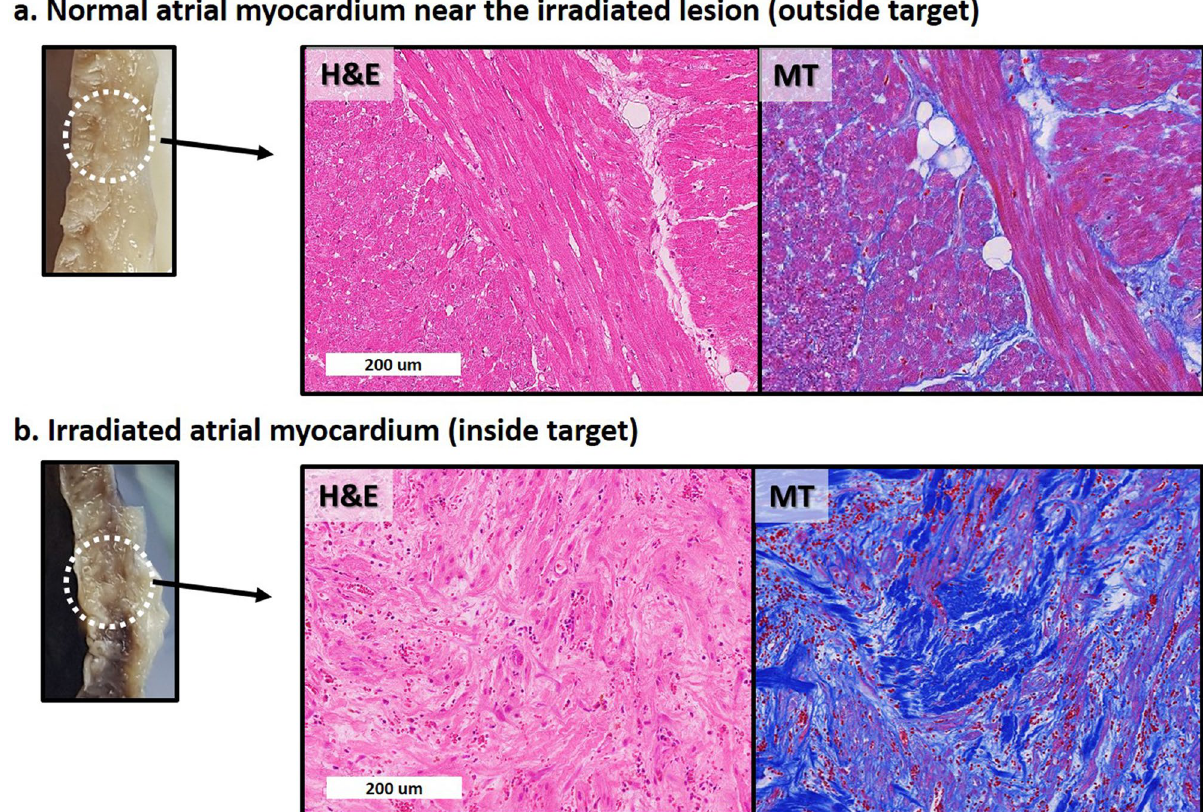
Figure 5. Histologic changes after irradiation observed at 4 months. A visually definite transmural necrotic lesion is observed on the irradiated area at 4 months. Compared to the normal atrial myocardium near the irradiated lesion ( a ), irradiated atrial myocardium ( b ) shows massive hemorrhage with anucleated wavy fibers with extensive interstitial fibrosis. H&E hematoxylin and eosin, MT Masson’s and therefore, we selected a higher RT dose of 33 Gy rather than a dose of 25 Gy used in the VT treatment with SABR and the irradiated atrial myocardium showed transmural fibrosis. The heterogeneity of the border zone between the irradiated and non-irradiated zones could be the arrhythmogenic substrate in the context of micro-reentry or triggered activity. However, the irradiated myo- cardium was well-demarcated from the adjacent normal myocardium, as displayed in Supplementary Fig. S4, and the width of the border zone was only a few hundred microns. The topic of the role of irradiated tissue as an arrhythmogenic substrate should be further elucidated in a future study. The PVs and LA posterior wall play an important role in AF initiation and maintenance 22 . Therefore, total PV isolation with or without posterior wall isolation from the LA is the standard treatment method. However, atrioesophageal fistula or phrenic nerve palsy, which are two major complications related to AF ablation, may occur during catheter ablation of the posterior parts of the PVs 23 . Like conventional catheter ablation, high dose radiation to the esophagus could be also related to the fatal adverse event as shown in the previous report 24 . Thus, we applied a modified circular box-lesion set anteriorly to all PVs and the LA posterior wall to save the esophagus and enhance target coverage. This novel target circular lesion included the posteroinferior part of the LA, part of the atrial septum, anterior LA roof, and the Coumadin ridge area between the LA appendage and the left PVs, which are traditional target areas for conventional AF ablation. We applied this design in both SR and AF models. The AF burden of one dog in the AF model was decreased after radiotherapy, although we could not verify whether this effect was a result of radiotherapy. Although safety is a crucial issue for application of SABR in AF treatment, the purpose of the present work was to assess the feasibility of PV isolation using a box design, and to enhance feasibility, safety measurements were considered less importantly. Therefore, in the current study, we could not ensure the safety of radiotherapy for AF treatment. One dog with SR without cardiac monitoring died suddenly. This occurred 1 week before the intended harvest day. Unfortunately, we could not verify the cause of death from the autopsy results, and the association between sudden death and radiotherapy cannot be ruled out. When we investigated the heart dur- ing the autopsy, we found extensive transmural lesions across the atrium (Supplementary Fig. S5 online). The sinus or atrioventricular node area was visually and histopathologically preserved. However pump failure and a fatal ventricular arrhythmia in the context of LV acute dysfunction cannot be excluded. The overall reduction of LV function without apparent pathological structural changes was also reported by Zei et al. 14 . The study by Hohman et al. 25 reported cases of sudden death and a clear dose response relationship with the LV dose. In the